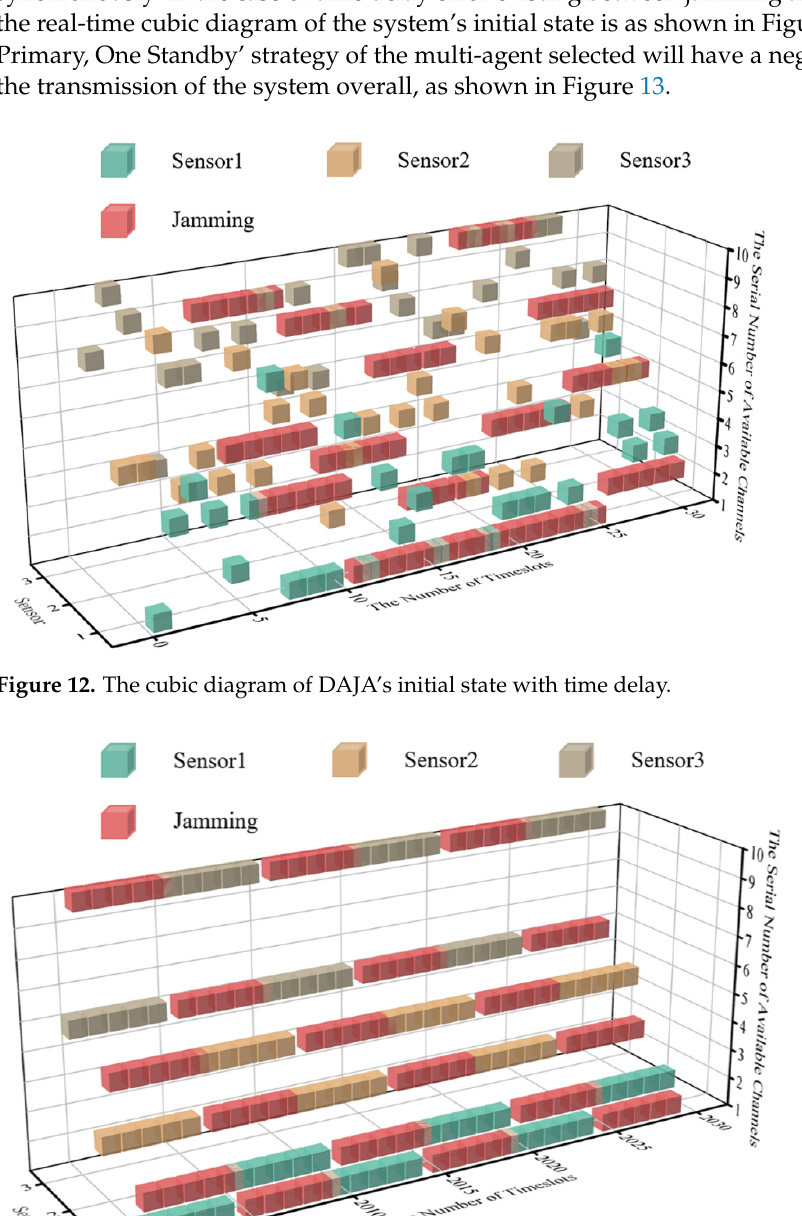
Figure 13. The cubic diagram of DAJA’s convergent state with time delay.